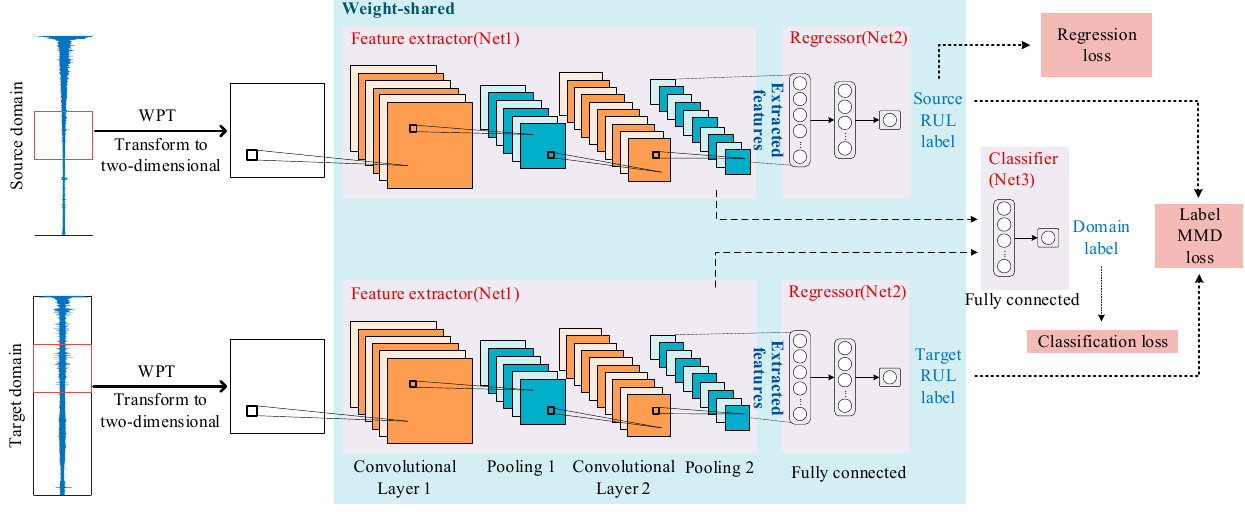
Figure 1. The proposed RUL prediction method.